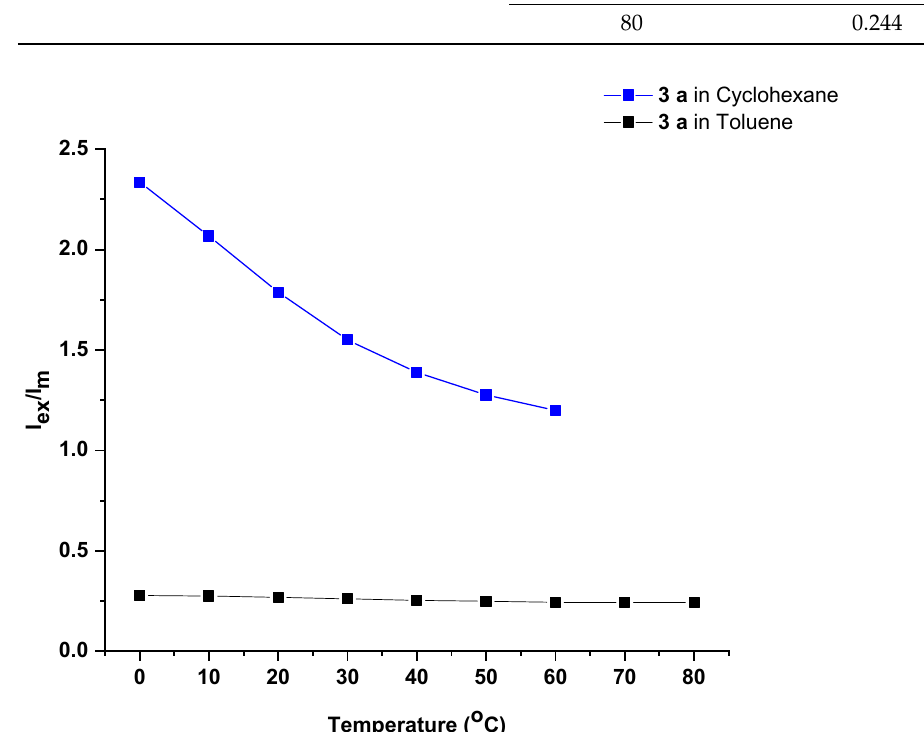
Figure 26. The I ex /I m ratio dependence on the temperature in cyclohexane and toluene solutions of polymer 3 a at different temperatures.